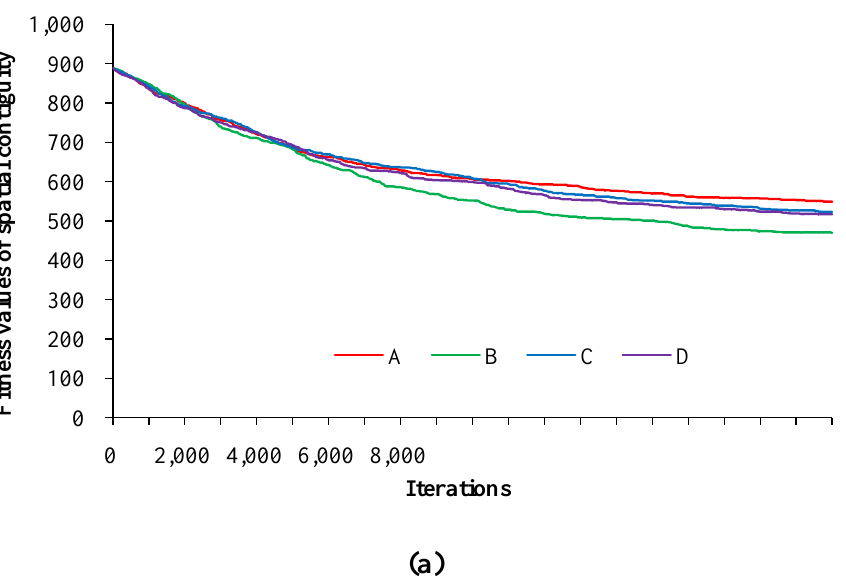
Figure 6. The objective fitness values during the optimisation of basic farmland preservation zone: ( a ) spatial contiguity; ( b ) shape